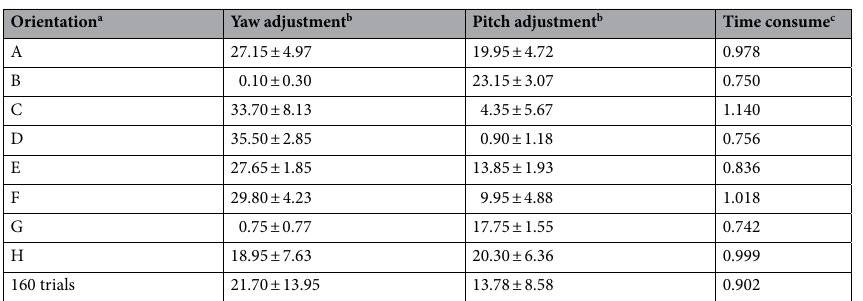
Table 2. Results of yaw and pitch adjustments in lumen alignment experiments with 8 directions using model D. a Eight starting positions were designed and 20 trials were performed for each position for a total of 160 trails; A. northwest B. north C. northeast D. east E. southeast F. south G. southwest H. west. b Degree of adjustment of yaw angle and pitch angle expressed as mean ± standard deviation. c Time spent adjusting yaw and pitch angles for each position, expressed as mean time in